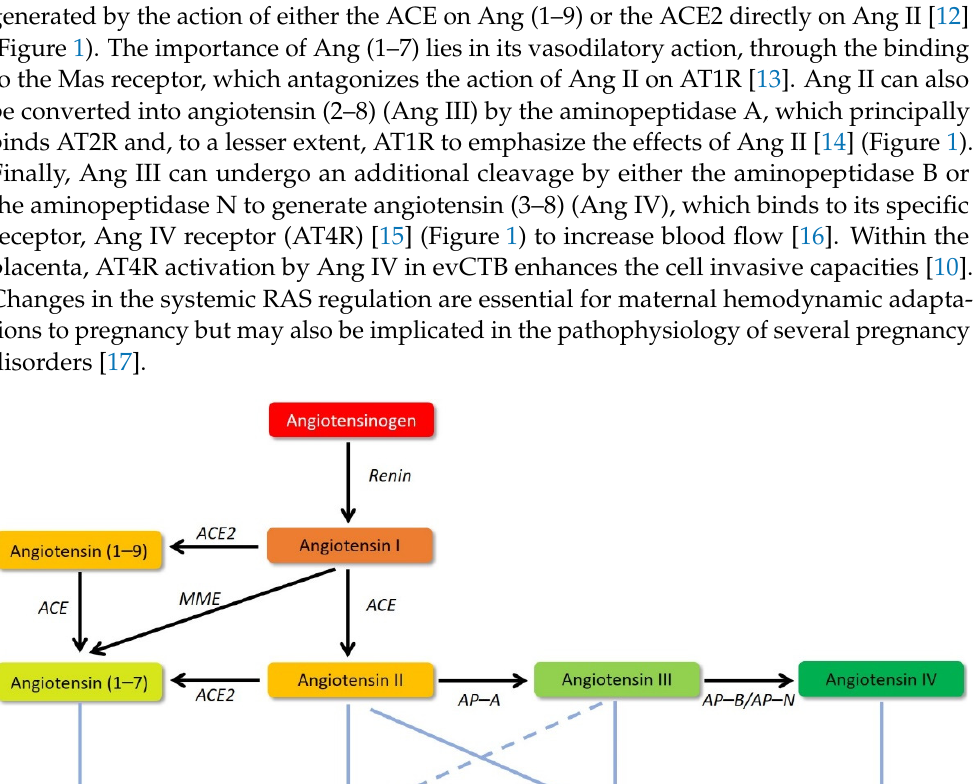
Figure 2. Role of the uteroplacental renin–angiotensin system (RAS) in placental development and function. evCTB: extravillous cytotrophoblasts; STB: syncytiotrophoblast.